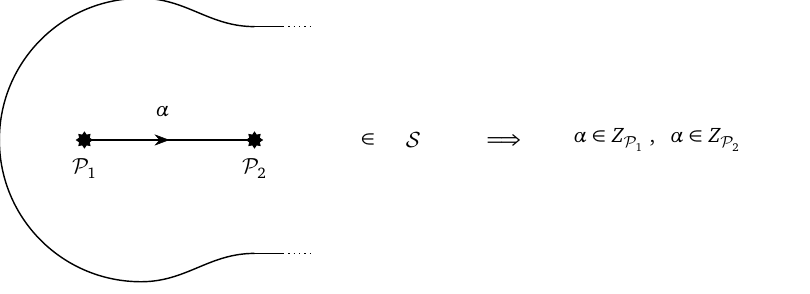
Figure 9: If a 1-cycle in S carrying α ∈ (cid:98) Z ends on punctures of types P